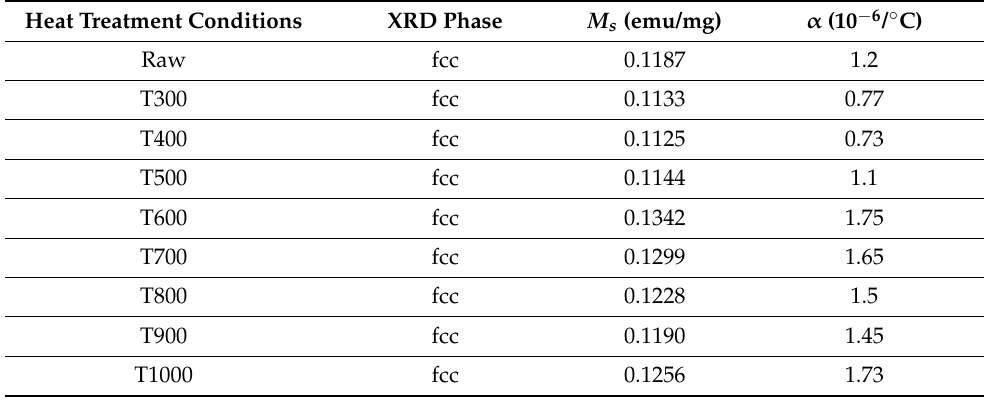
Figure 2. ( a ) The coefficient of thermal expansion ( α ) as the function of the heat treatment temperature ( T ). ( b ) Saturation magnetization M s as a function of heat treatment temperature ( T ) extracted from M–H loops. Table 2. Different heat treatment conditions, XRD phase, saturation magnetization ( M s ), and coeffi- cient of thermal expansion ( α ).